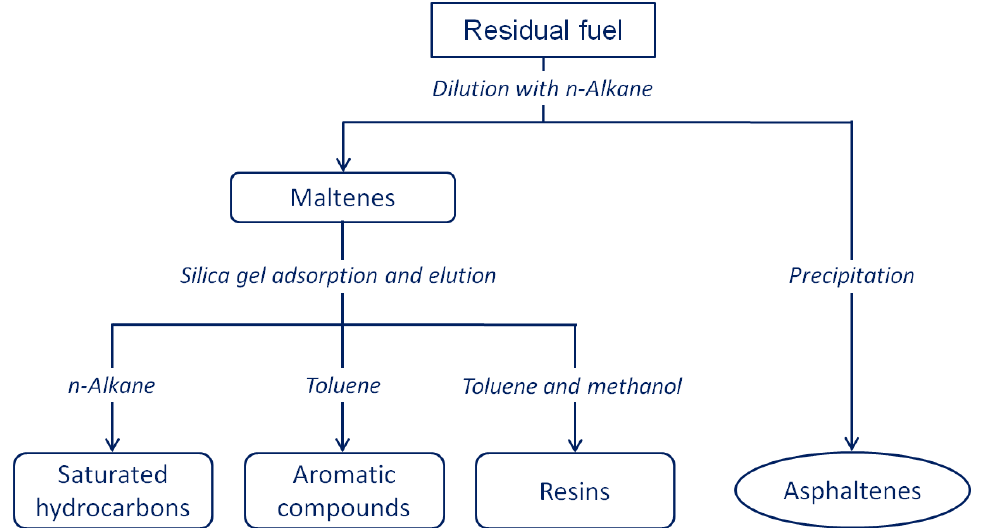
Figure 3. Residual fuel dilution scheme to determine the group composition of